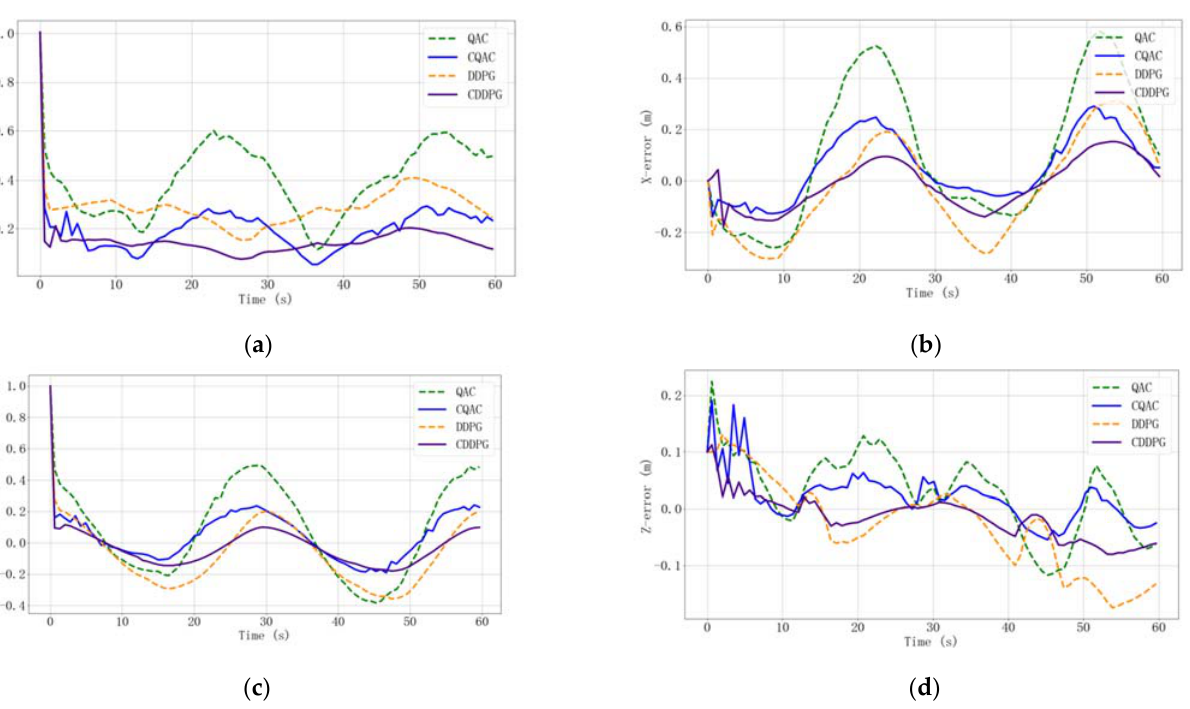
Figure 14. ( a ) Composite tracking error of four algorithms; ( b ) X ‐ direction tracking error of four algorithms; ( c ) Y ‐ direction tracking error of four algorithms; ( d ) Z ‐ direction tracking error of four rithms; ( c ) Y-direction tracking error of four algorithms; ( d ) Z-direction tracking error of four algorithms.